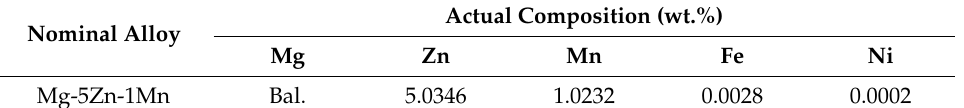
Table 1. Chemical composition of the studied alloy.